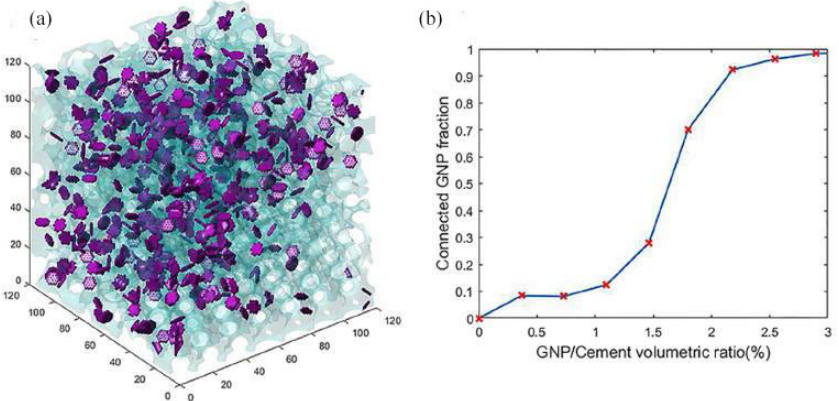
Figure 24. GNP/cement composites ( a ) Simulation model; ( b ) Simulation result. Reprinted from